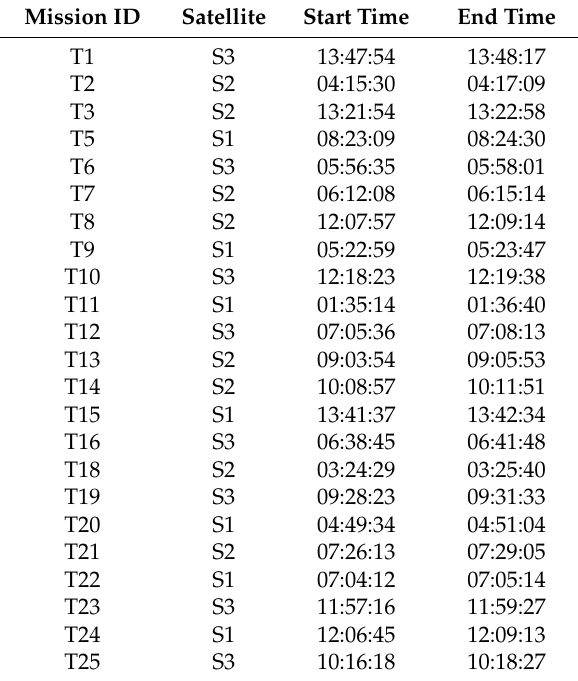
Table 11. Initial scheduling plan.